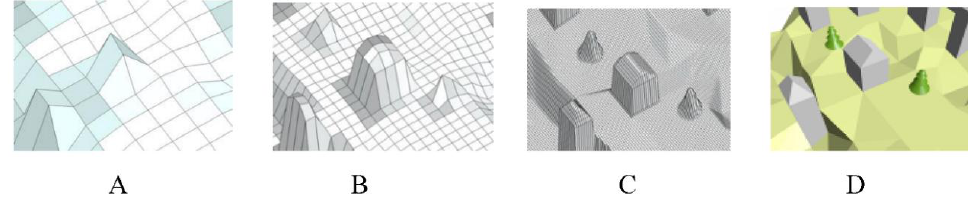
Figure 1. ( A – C ) Raster models of environment with different resolution; and ( D ) vector model of environment.